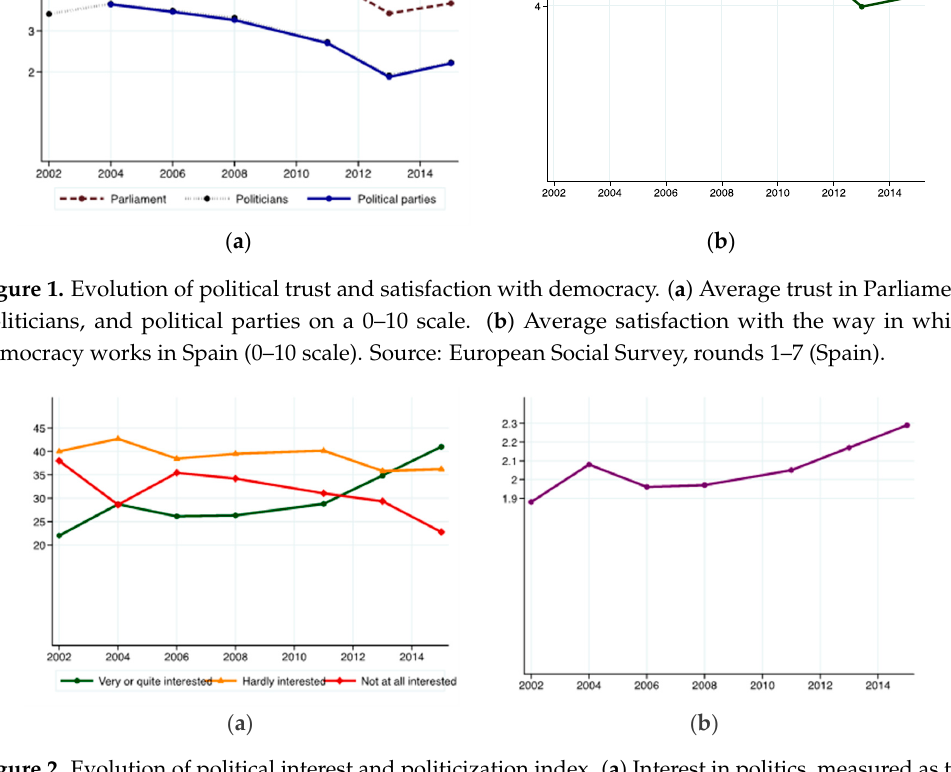
· 4 + p 2 · 3 + p 3 · 2 + p 4 · 1 p 1 + p 2 + p 3 + p 4